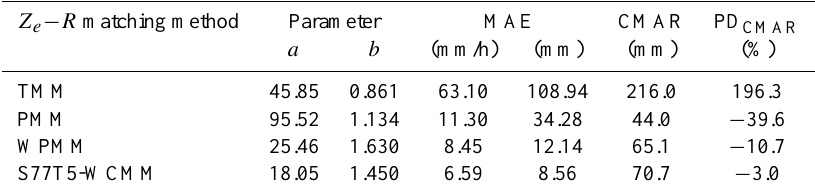
Table 7. Performance of Z e − R relationships by different Z e − R pair matching techniques. Z e − R matching method